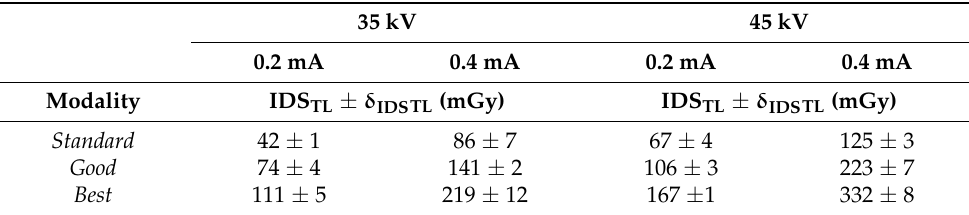
Table 6. Imparted Dose at Surface measured in the lucite block (IDS TL ) under CPE for the different kV and mAs settings and modalities of image